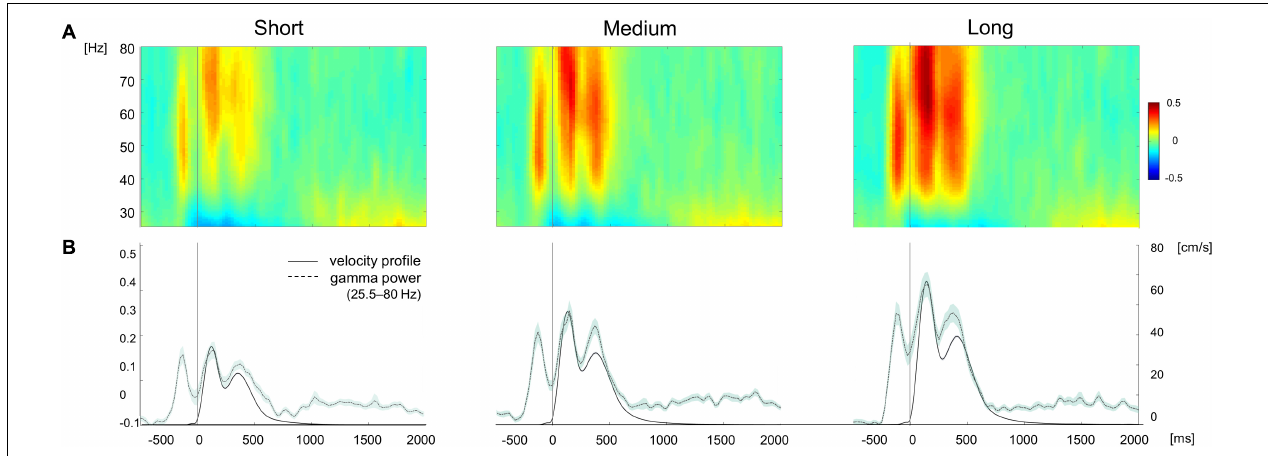
FIGURE 4 | (A) EEG time-frequency plots of the gamma band range (25.5–80 Hz) during movement separately averaged for target displayed at short (4 cm), medium (7 cm), and long (10 cm) distances. (B) Time course of gamma power (black and velocity profile averaged across electrodes and subjects for each target distance. Shaded area in the power and velocity profiles represents the standard error. The color bar represents amplitude changes in the time-frequency signal normalized by the average spectral